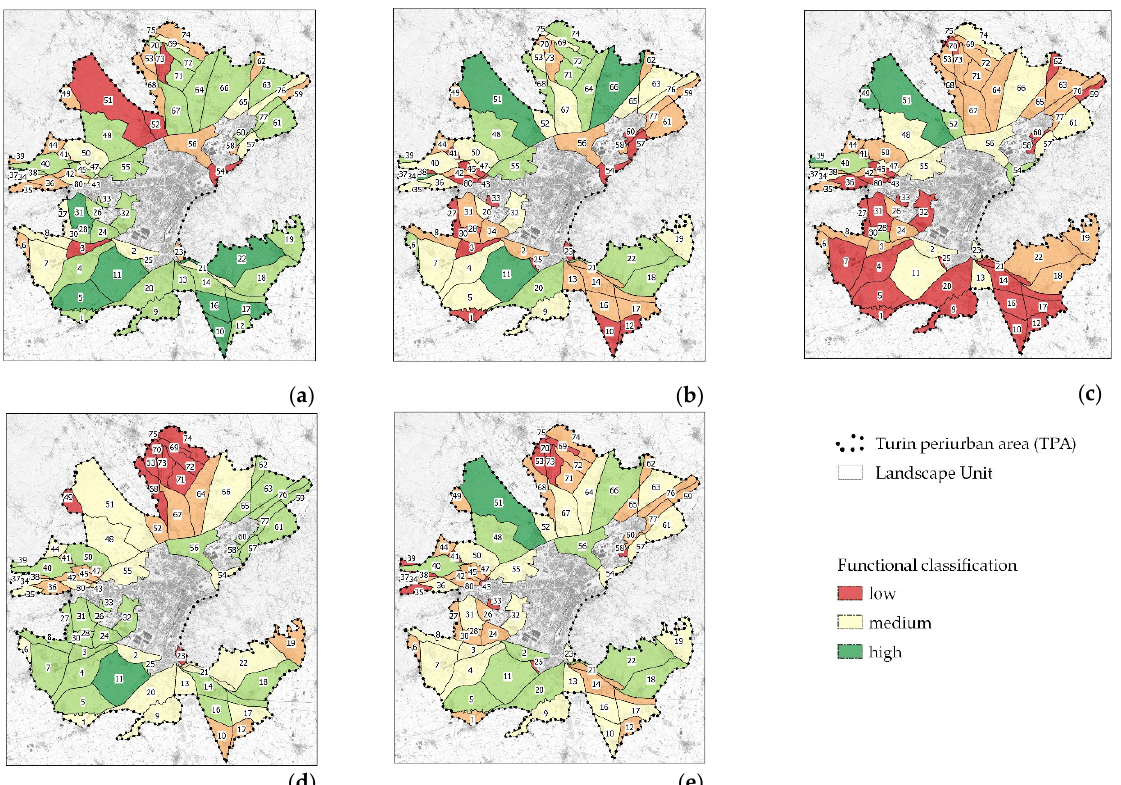
Figure 6. Functional classification according to the following functions: ( a ) food provision; ( b ) historical and cultural; ( c ) ecological; ( d ) scenic; ( e ) recreational.